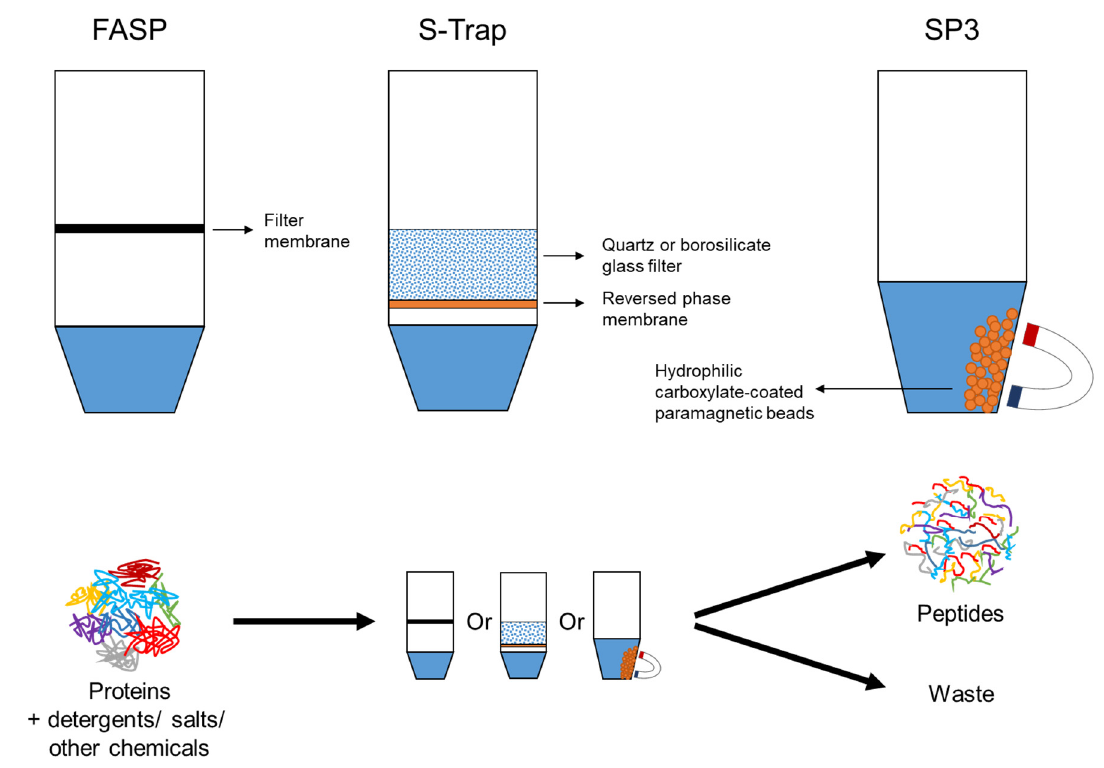
Figure 2. Sample preparation with FASP, S-Trap, and SP3 in bottom-up proteomics.